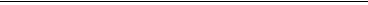
Figure 2. The production cross sections for squarks and gluinos at the LHC with in the MSSM (left) and the MRSSM (right). It is summed over (cid:12)ve (cid:13)avours, all possible squark \chiralities" and for squark-squark and squark-gluino production also the charge conjugated pro- cesses are taken into account. The top row contains results in function of the gluino mass (with squark masses (cid:12)xed to 1.5 TeV), the bottom one in function of squark masses with the gluino mass (cid:12)xed to 2 TeV. The PDF set used is MMHT2014LO [18]. As renormalisation and factorisation scale (cid:22) R = (cid:22) F = m 1 + m 2